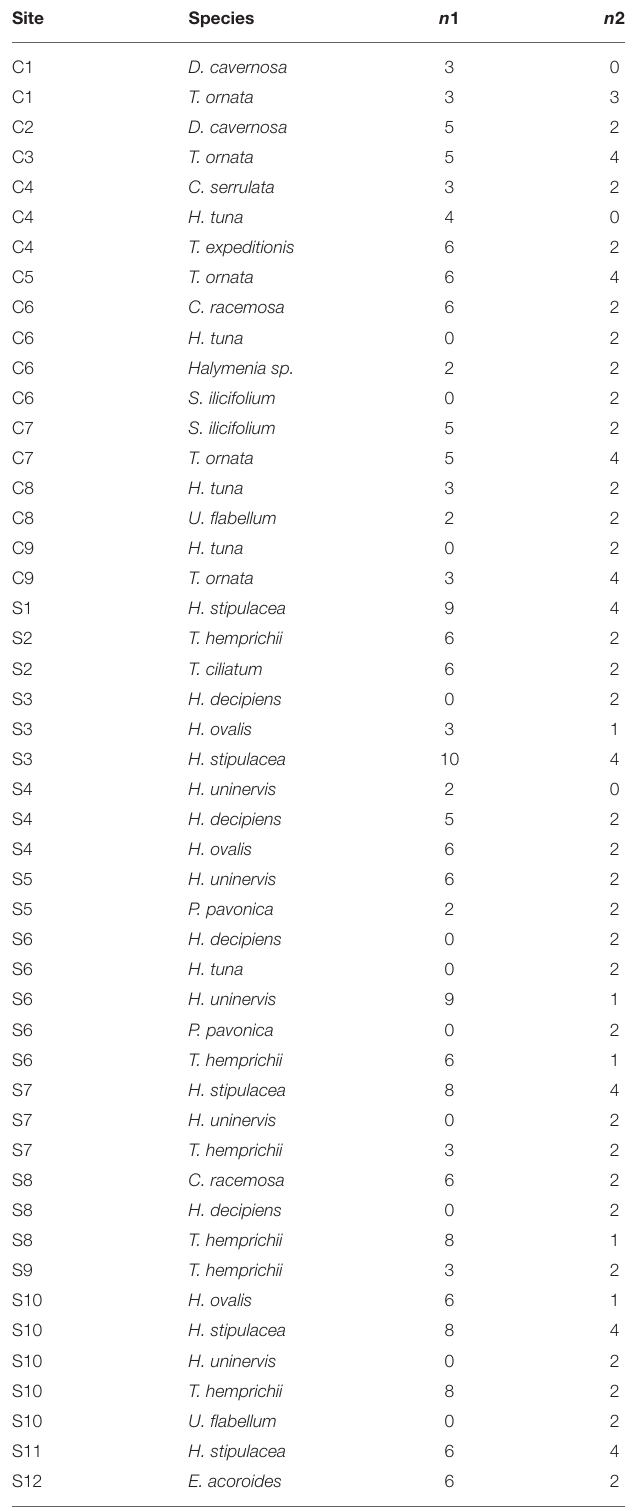
TABLE 2 | Number of replicates collected on each study site per species.